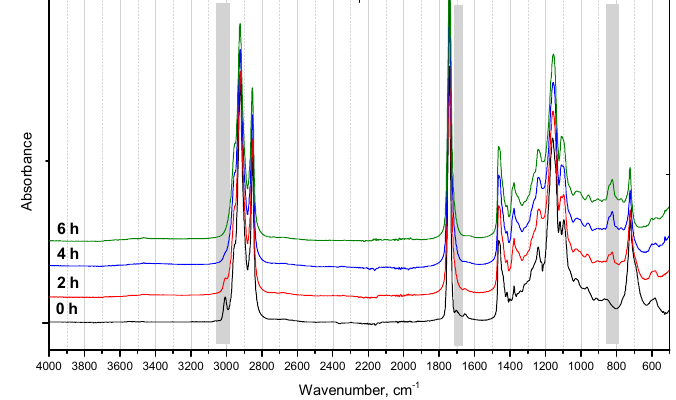
Figure 5. FTIR spectra of samples taken during epoxidation process of Epox_8_200-400.